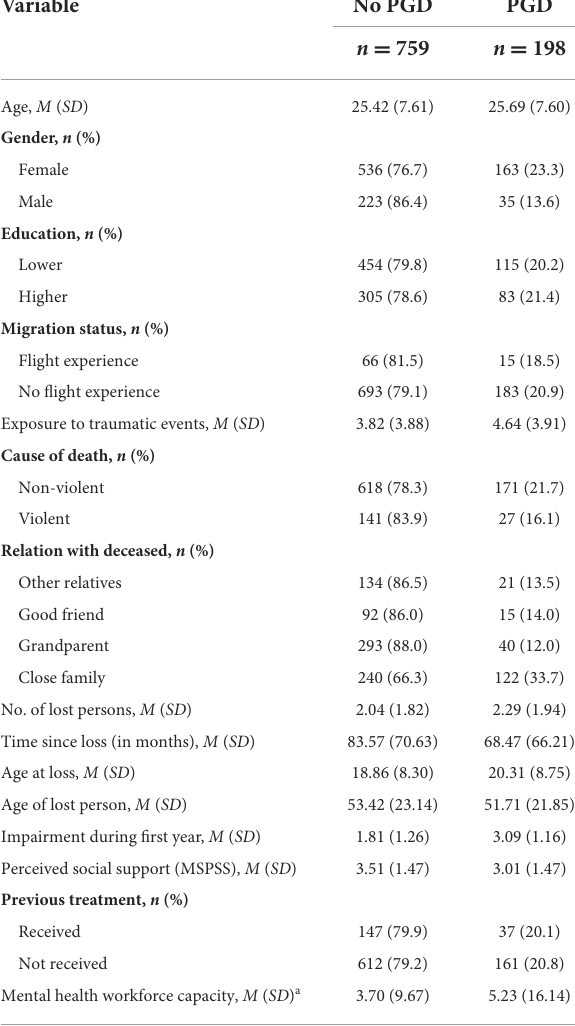
TABLE 3 Demographic, loss-, trauma-, and support-related variables of participants with and without PGD according to ICD-11.